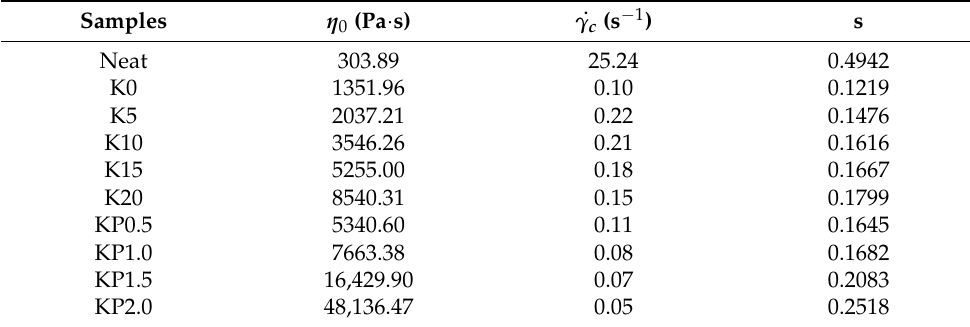
Table 8. Parameter values of Carreau